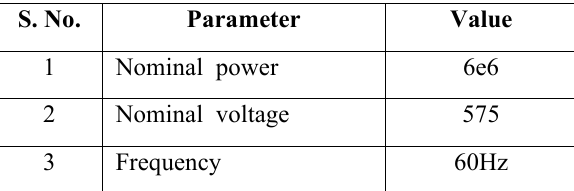
Table 5. Specifications of the induction generator S. No.